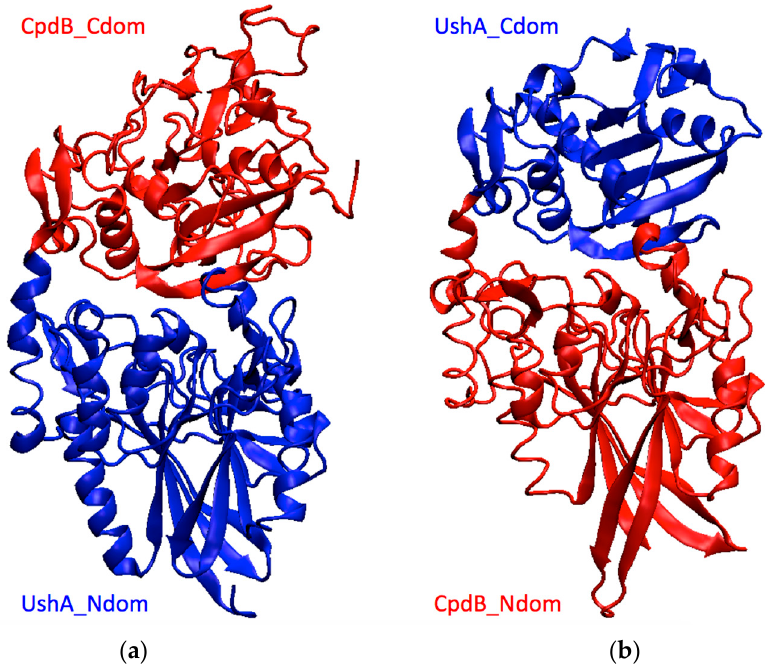
Figure 2. Models of the chimeras obtained by homology. ( a ) UshA_Ndom–CpdB_Cdom, ( b ) CpdB_Ndom–UshA_Cdom. Blue, UshA domains; red, CpdB domains.